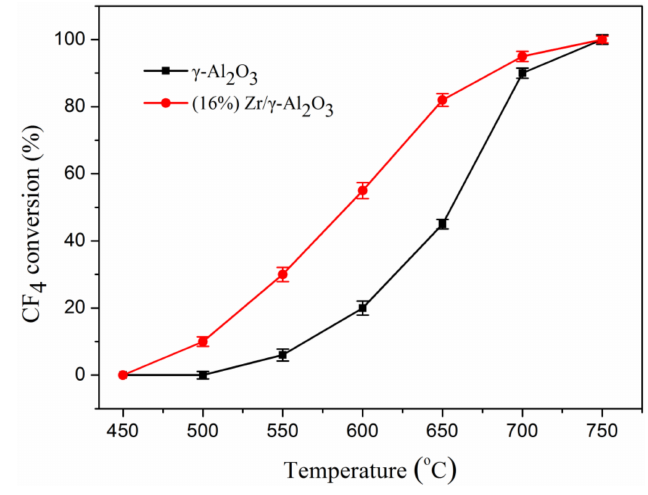
Figure 6. CF 4 conversion reaction over γ -Al 2 O 3 and Zr/ γ -Al 2 O 3 catalyst. The long-term tests are conducted to investigate the stability of catalysts, as shown in Figure 7. The (16%) Zr/ γ -Al 2 O 3 catalyst exhibits excellent catalytic activity and stability compares to other works listed in Table 3. With time increasing, the catalytic efficiency of bare γ -Al 2 O 3 decreases rapidly from 30 h (42%) to 60 h (8%) while the efficiency of (16%) Zr/ γ -Al 2 O 3 still remains 76%. The large difference between the conversion performances and stabilities in CF 4 decomposition are due to the modification by Zr element, which provides more Lewis acidic sites.